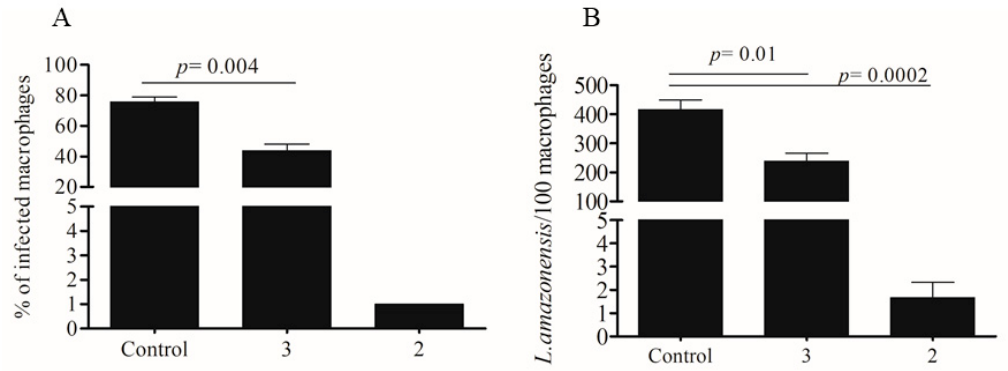
Figure 3. Effect of compounds 2 and 3 against amastigotes of L. amazonensis . Macrophages from peritoneal exudate were collected from BALB/c mice and infected with L. amazonensis promastigotes in the stationary growth phase during 6 h. The cells were washed and incubated during 24 h without treatment. After this period, the macrophages were treated with the compounds at 6 µ M for 48 h. ( A ) Percentage of infected cells was evaluated by counting of 100 cells as well as the parasite number. ( B ). p -value was measured by unpaired t-test compared to control group.